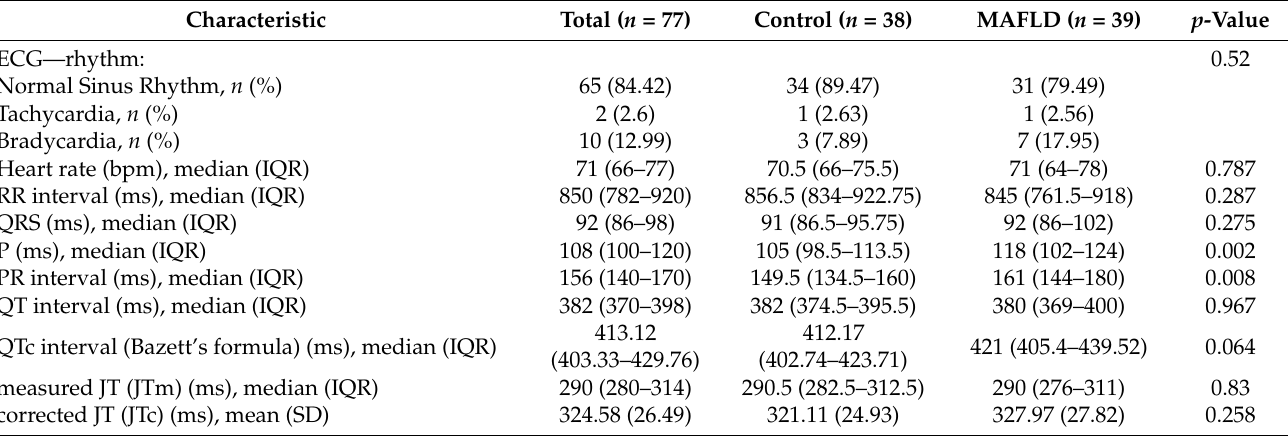
Table 4. Assessed electrocardiogram